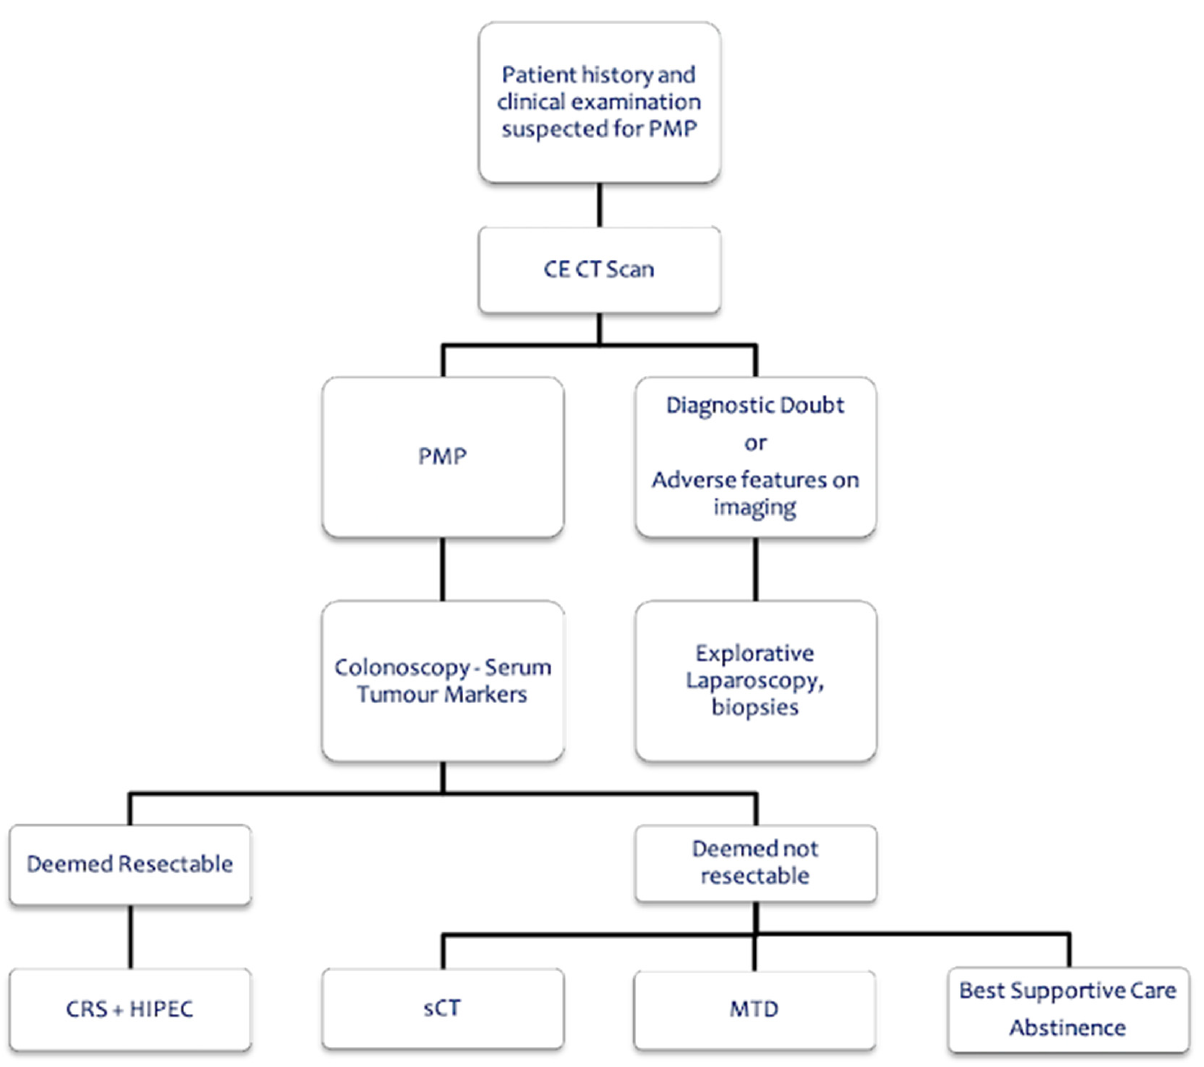
Figure 1. Pseudomyxoma peritonei management. CE CT Scan = Contrast Enhanced Computed To- mography; PMP = PseudoMyxoma Peritonei; CRS = Cytoreductive Surgery; HIPEC = Hyperthermic IntraPEritoneal Chemotherapy; sCT = Systemic ChemoTherapy; MTD = Maximal Tumor